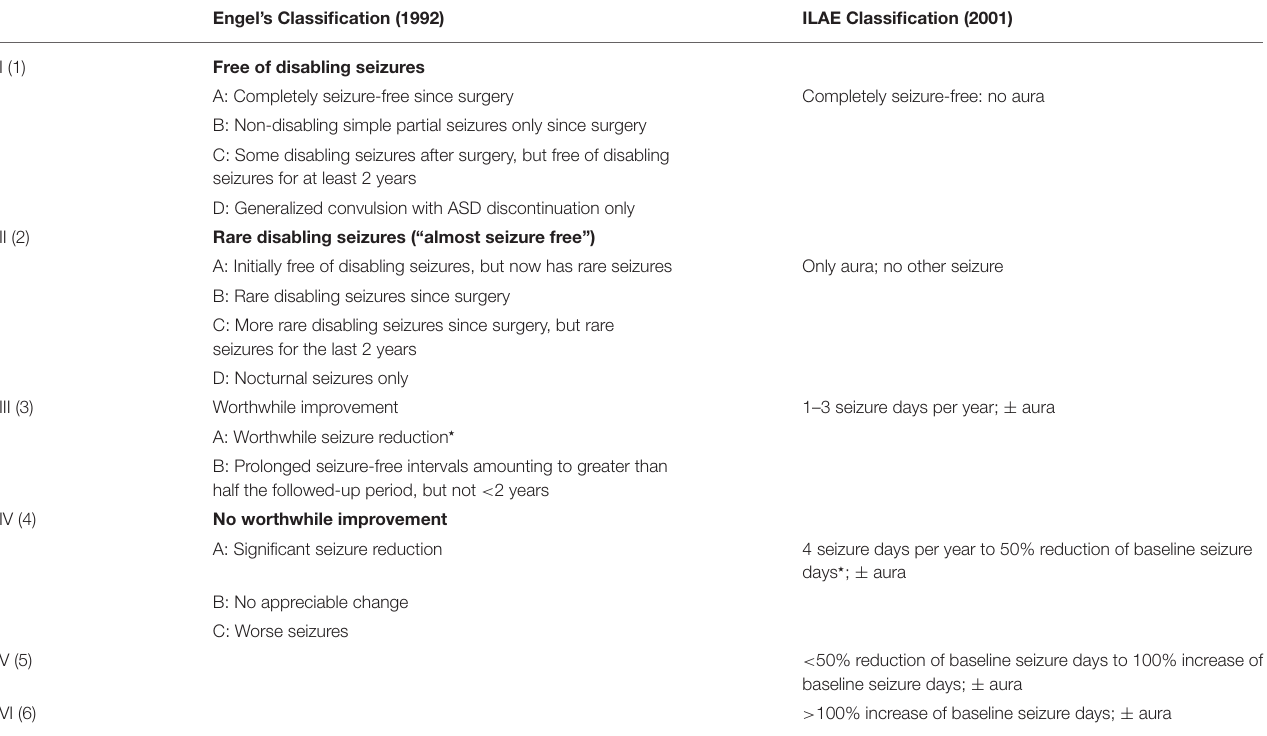
TABLE 2 | Classification systems of surgical seizure outcome. Engel’s Classification